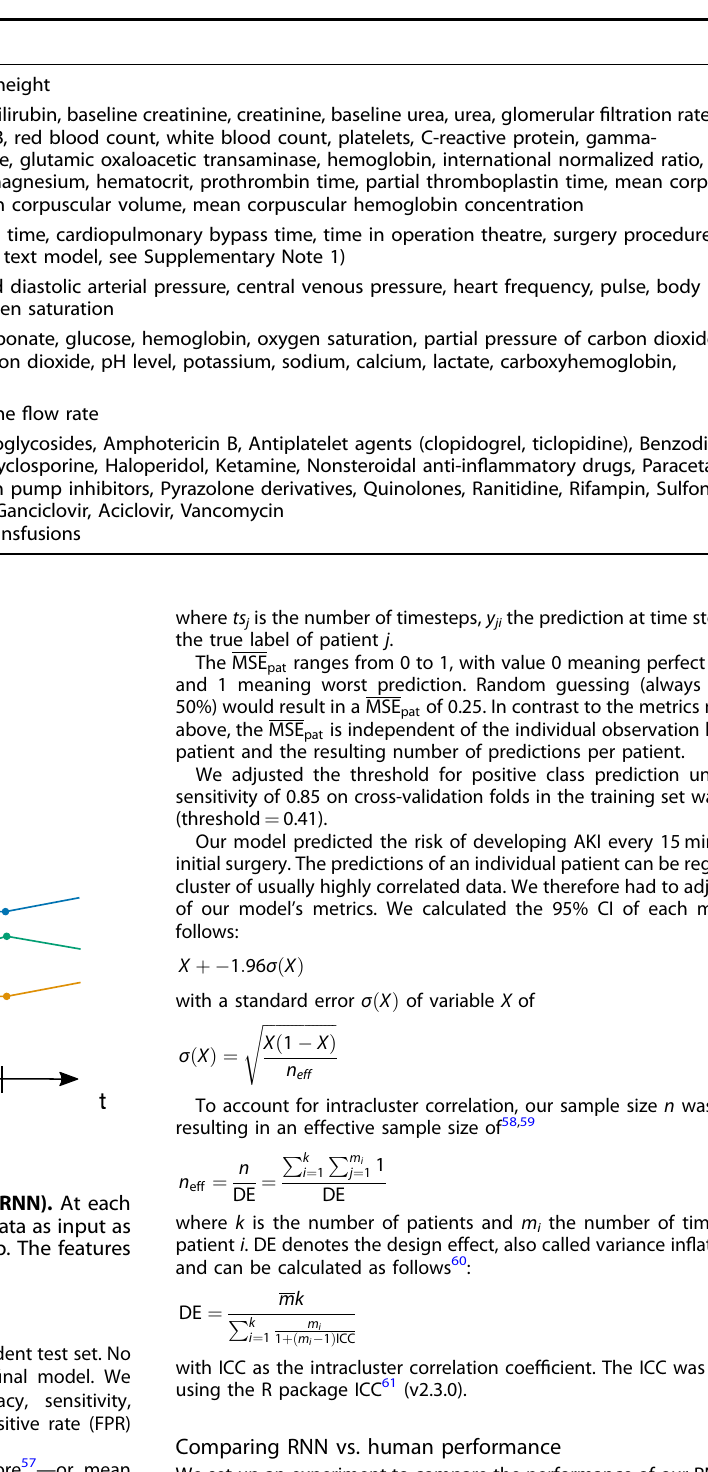
Table 5. Input feature overview.